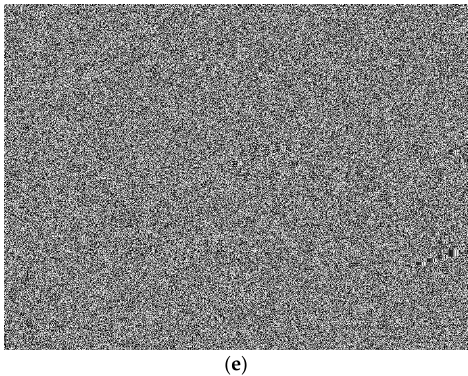
Figure 4. Airfield and its corresponding encryption images. ( a ) Airfield, ( b ) encryption image of the proposed algorithm, ( c ) encryption image of Zhang’s algorithm, ( d ) encryption image of Hraoui’s algorithm, and ( e ) encryption image of Kalubandi’s algorithm.